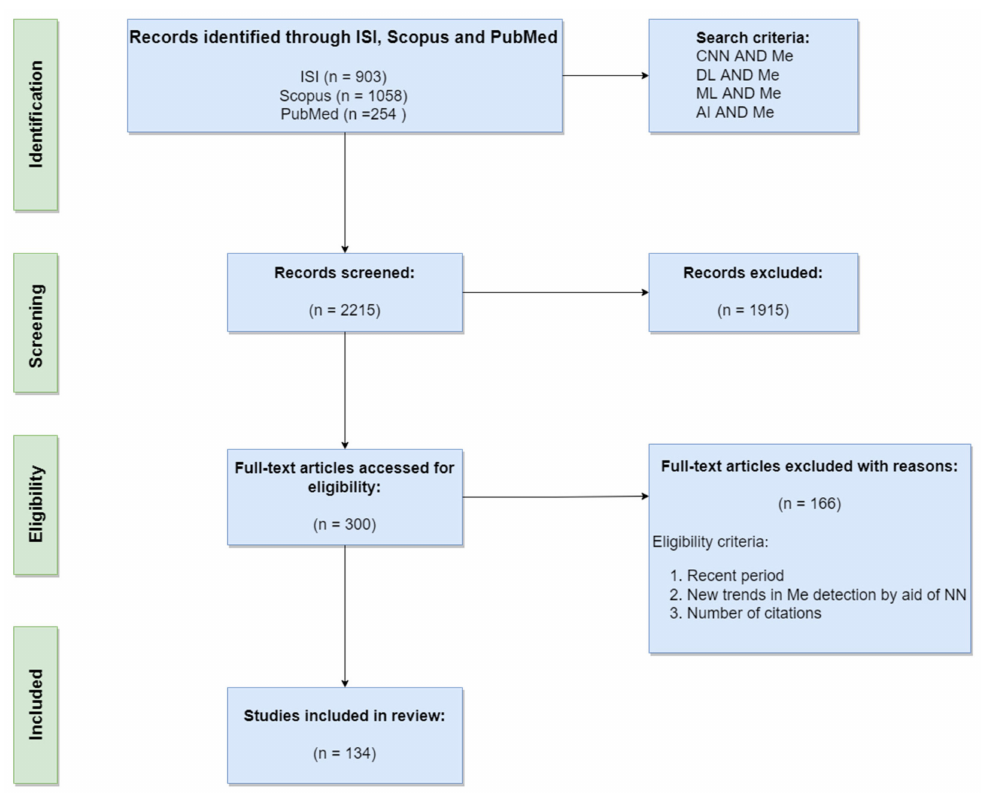
Figure 4. PRISMA flow diagram of our